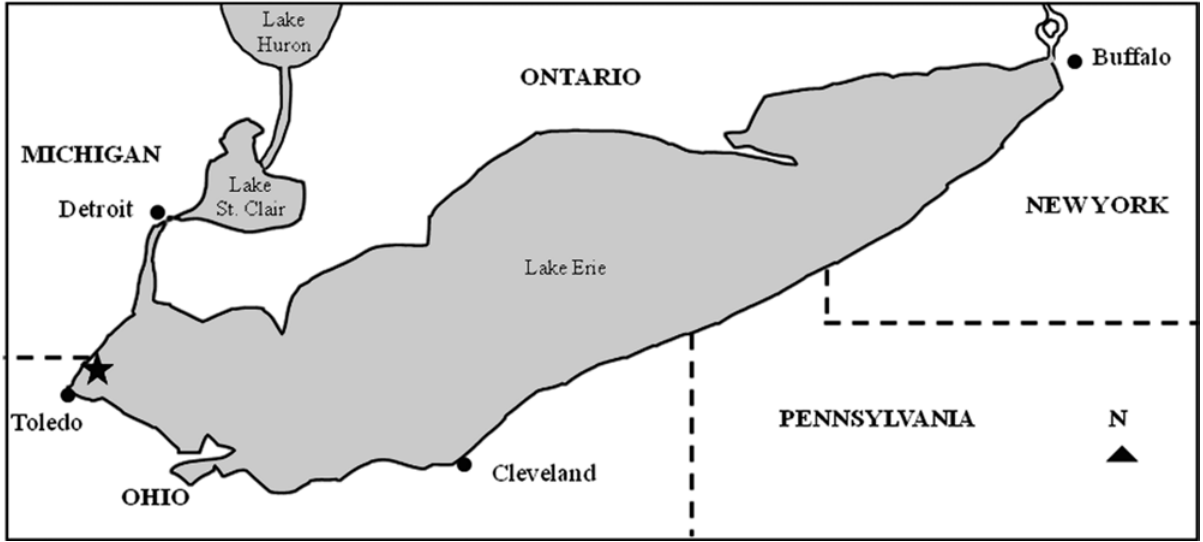
Fig 1. – The lake Erie Watershed is connected in the east to lake Ontario by the Welland canal and in the west to lake huron via the Detroit River, lake St. clair, and the St. clair River. The black star indicates the commercial fishing trap nets (41° 46’ 00.74” N, 83° 24’ 58.09” W) in lake Erie from which leeches were collected during this study.